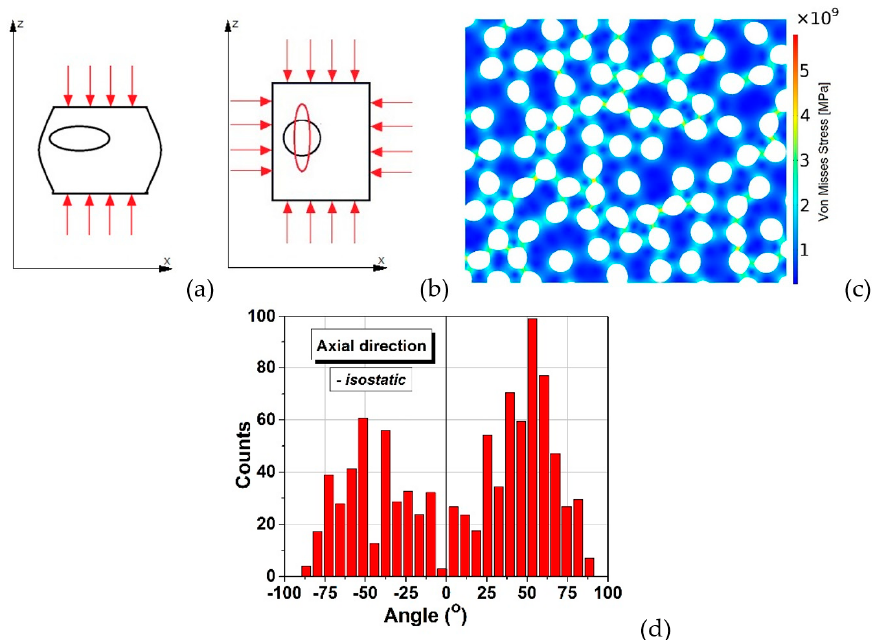
Figure 6. Schematic of isostatic pressing: ( a ) pressure applied only along the cylinder axis, ( b ) after isostatic pressing and deformation; ( c ) isostatically deformed structure; ( d ) angular distribution of inclusions derived for the case of isostatic pressing.